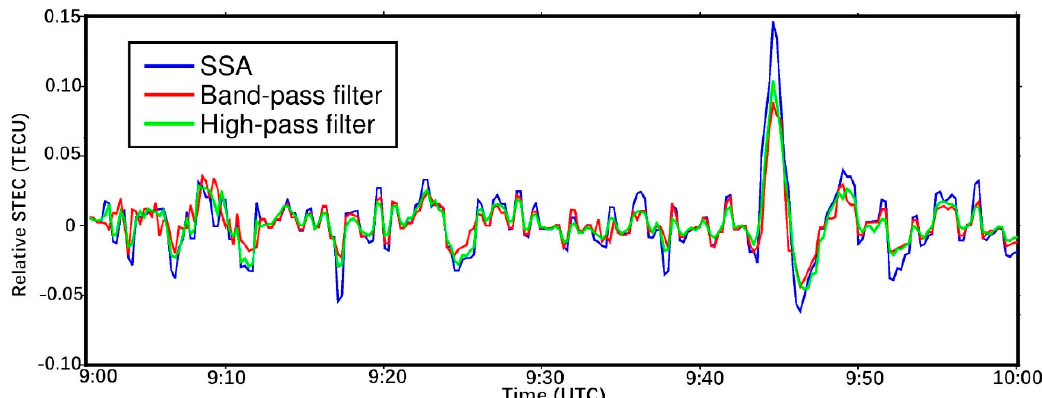
Figure 2. Ionospheric disturbances of the line of sight between the station av07 and global positioning system (GPS) satellite 05 extracted by three methods.